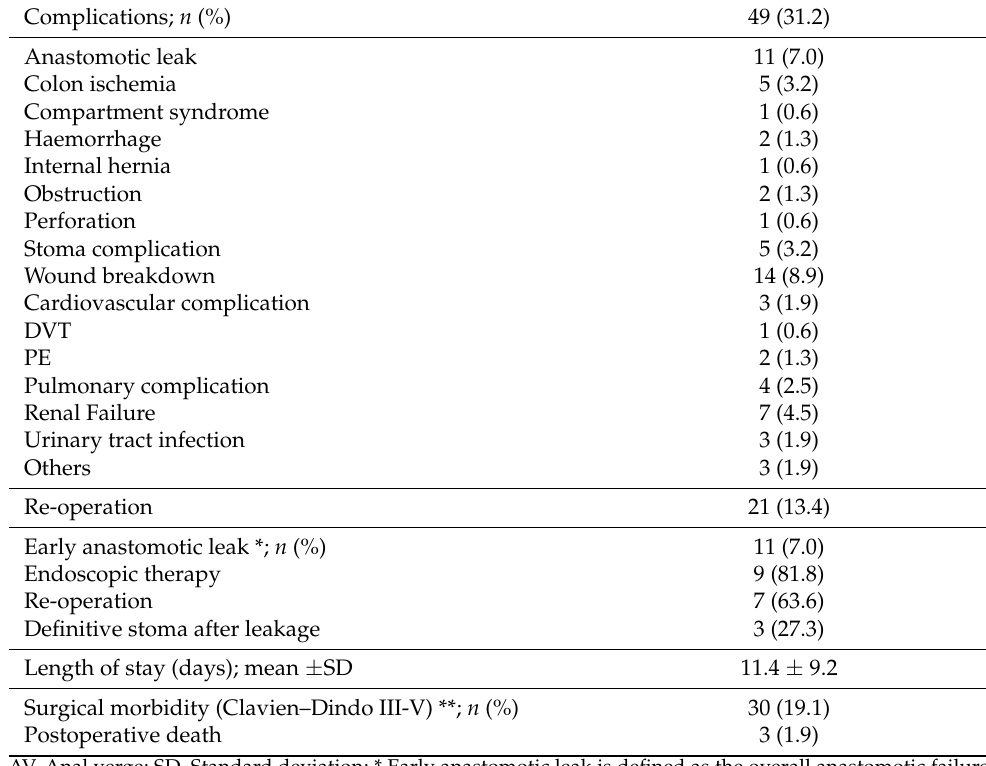
Table 3. Postoperative Outcome ( n = 157).